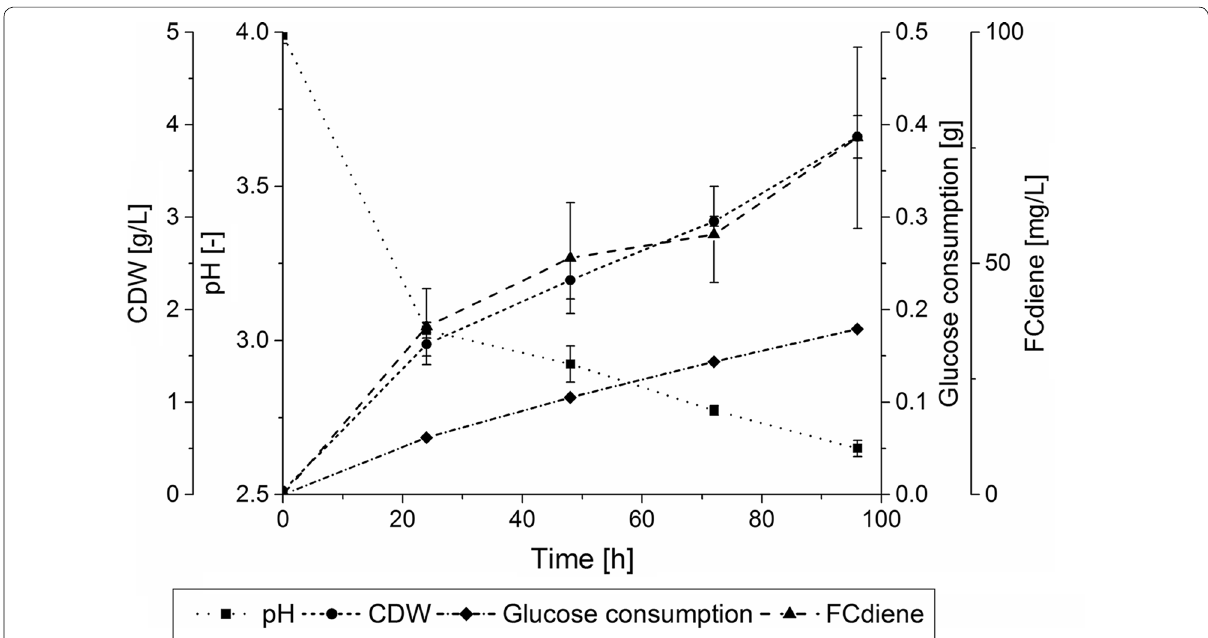
Fig. 1 Fed-batch reference fermentation of S. cerevisiae growing in SD medium with glucose FeedBeads ® as sole carbon source. Cell dry weight concentrations, pH, glucose consumption and FCdiene concentrations are shown. Error bars give the standard deviation of three biological